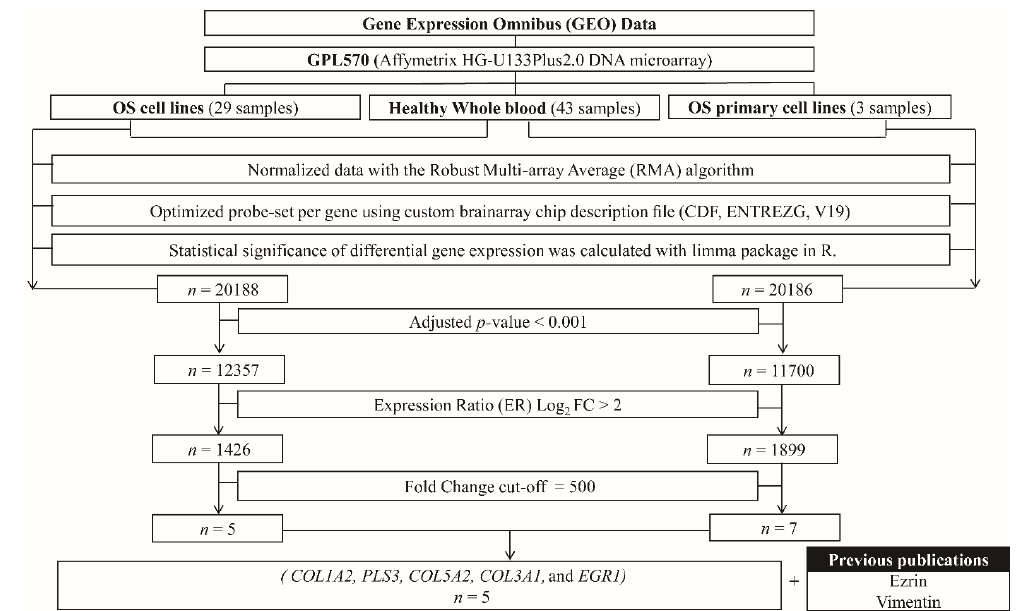
Figure 3. Diagram of the selection procedure for candidate genes. OS, osteosarcoma; COL1A2 , collagen type-I alpha-2 chain; PLS3 , plastin-3; COL5A2 , collagen type-V alpha-2 chain; COL3A1 , collagen type-III alpha-1 chain; EGR1 , early growth response protein 1; VIM , vimentin.